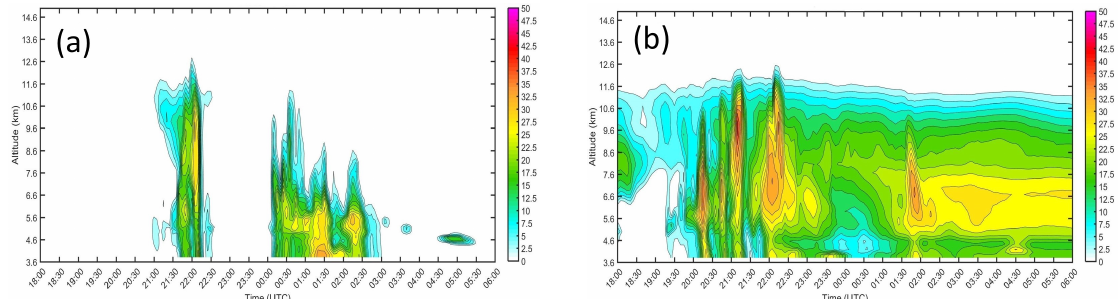
Figure 16. Time series of mean reflectivity (dBZ) over the Huancayo observatory obtained from the ARPS model (resolution: 0.5 km) for the ( a ) TS2 event and ( b ) TS3